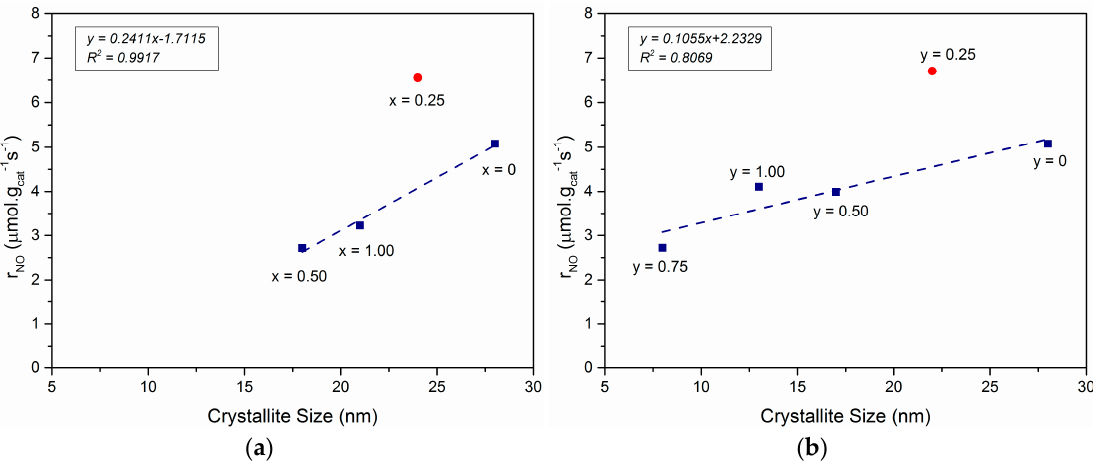
Figure 8. Rate of reaction as a function of crystallite size: ( a ) LaCo 1 – x Mn x O 3 ; ( b ) LaCo 1 – y Ni y O 3 Figure8. Rateofreactionasafunctionofcrystallitesize: ( a )LaCo 1 − x Mn x O 3 ;( b )LaCo 1 − y Ni y O 3 perovskites.